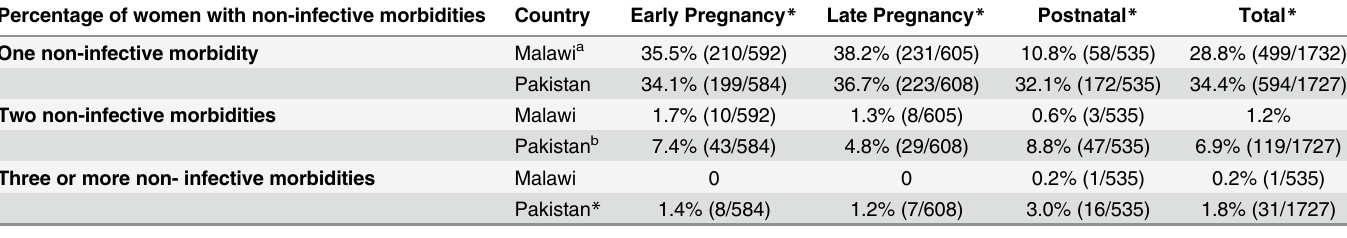
Table 6. Burden of non-infective morbidity among pregnant and postnatal women in Malawi and Pakistan. Percentage of women with non-infective